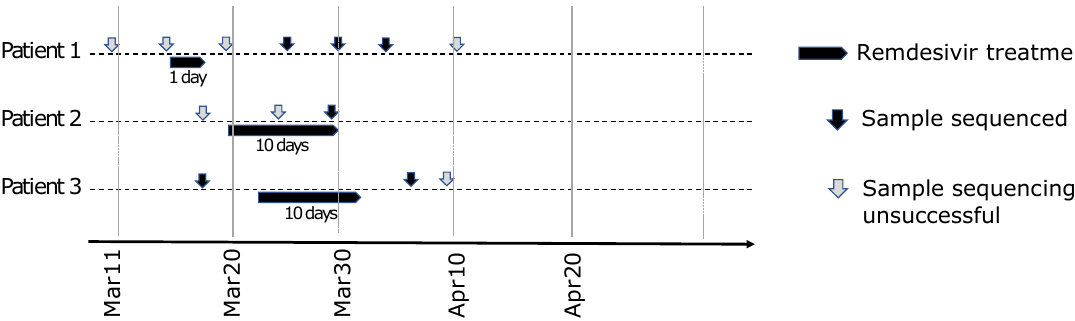
Figure 2. Chronology of remdesivir treatment in three local patients in the study period. Successfully sequenced samples are marked with black arrows. Grey arrows indicate samples that could not be sequenced for reasons of accessibility, sample quality or low viral load. Remdesivir treatment is indicated by black horizontal bars.